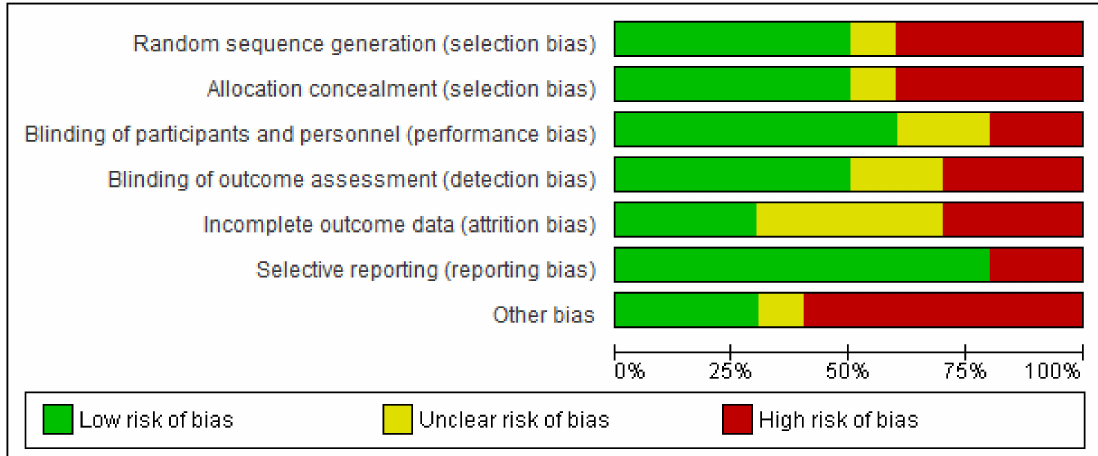
Figure 2. Risk-of-bias graph: reviews the authors’ judgments about each risk-of bias item presented as percentages across all of the included